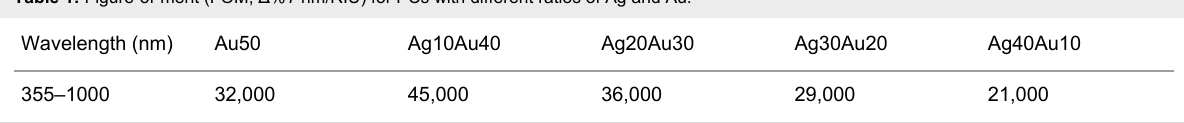
Table 1: Figure-of-merit (FOM, Δ % T ·nm/RIU) for PCs with different ratios of Ag and